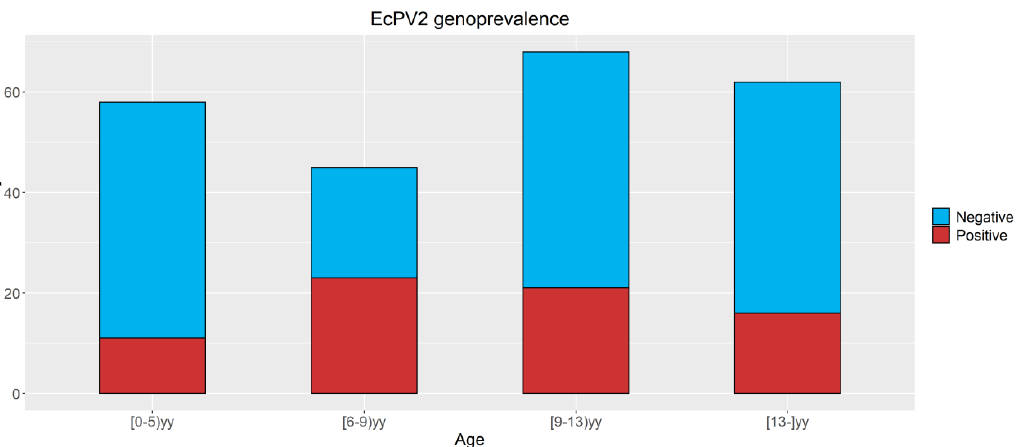
Figure 2. EcPV2 genoprevalence based on age classes. Positive (red part) and negative (blue part) number of subjects for EcPV2-L1.